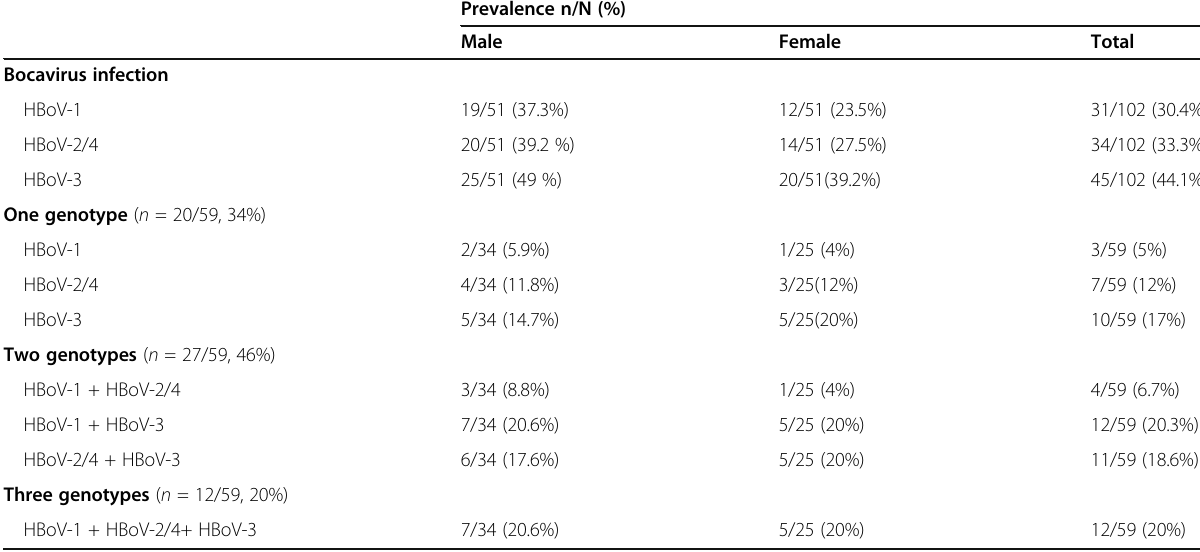
Table 2 Detection rates of bocaviruses genotypes in stool samples of under five children, Giza, Egypt